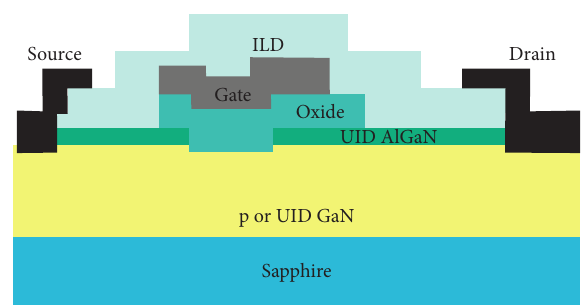
Figure 9: Schematic cross-sectional view of a lateral Ga-N hybrid